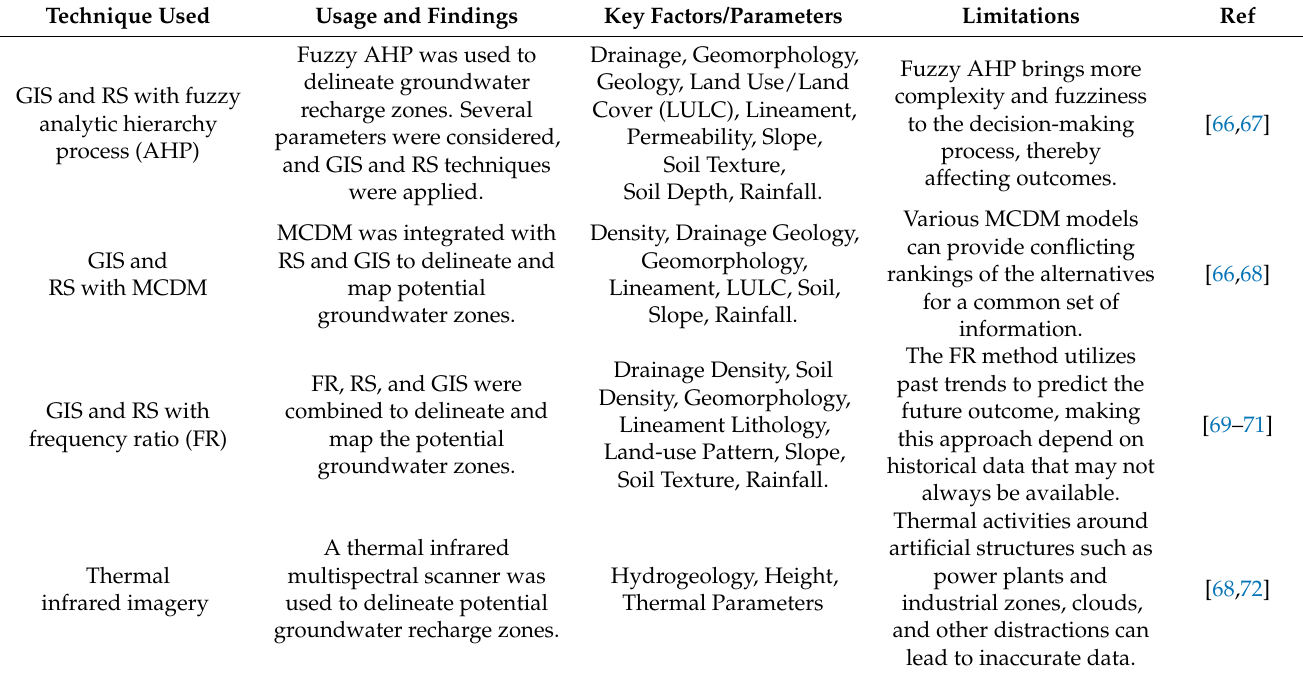
Table 1. Studies outlining techniques for groundwater